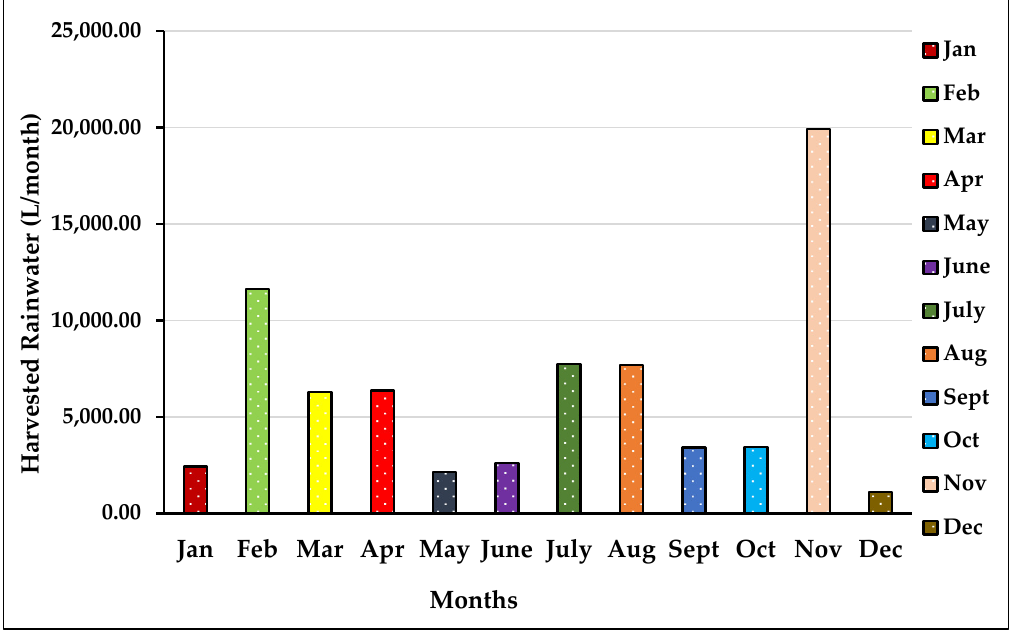
Figure 8. Monthly harvested rainwater in the study area.